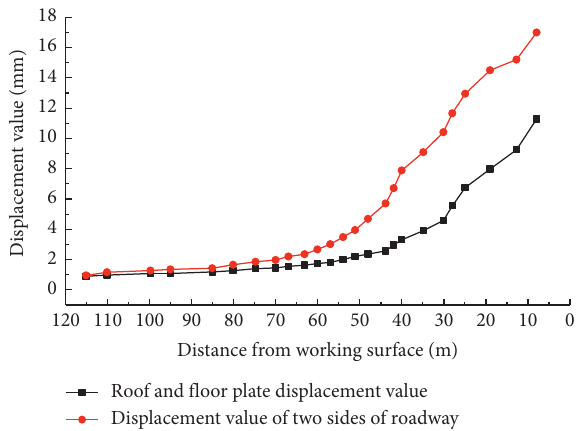
Figure 13: Variation curve of the surrounding rock displacement of in air-return roadway